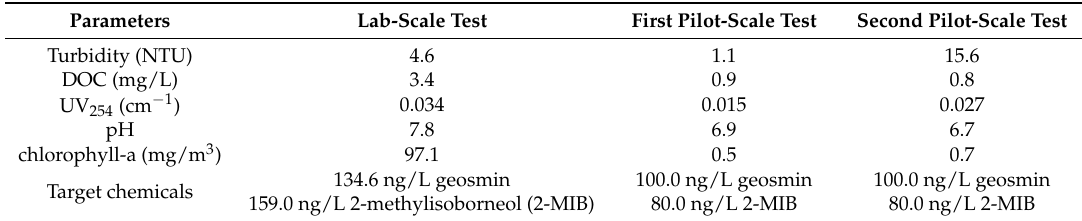
Table 1. Water quality parameters of raw water used in the lab-scale and pilot-scale